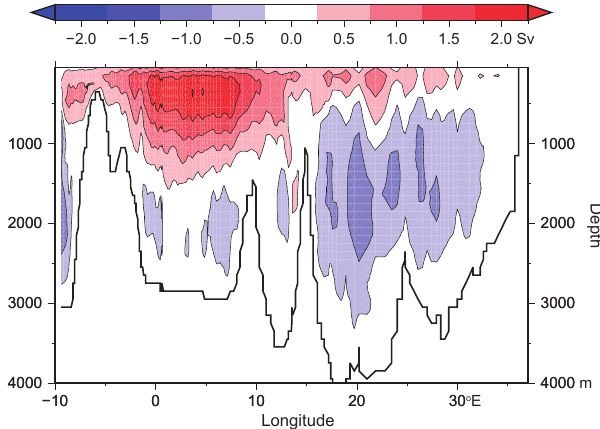
Figure 5. “Zonal” overturning stream function of the reference experiment. The contour interval is 0.5Sv. Positive values (red colours) indicate clockwise circulation in this view, negative values (blue) anti-clockwise